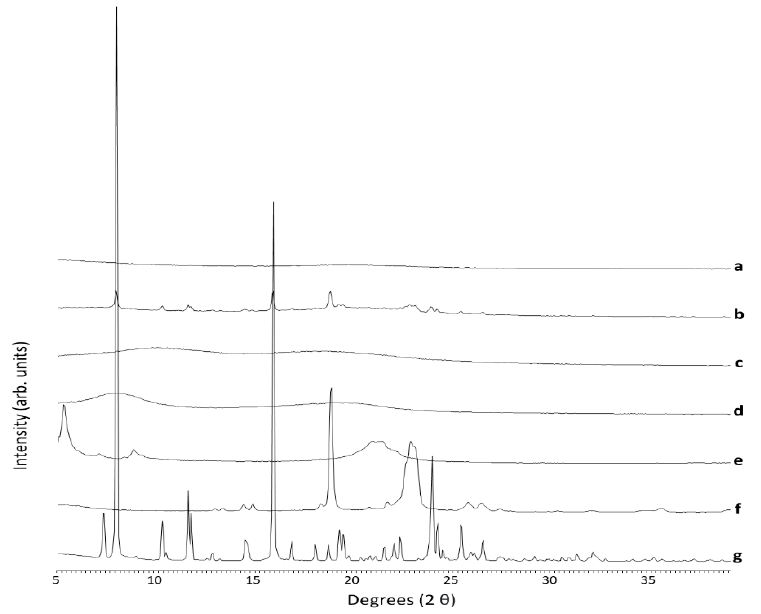
Figure 3. PXRD analysis. Key: ( a ) 3D printed minitablets, ( b ) Physical mixture, ( c ) Unprocessed HPMCAS, ( d ) Unprocessed HPC, ( e ) Unprocessed magnesium stearate, ( f ) Unprocessed PEG 4000, and ( g ) Unprocessed NFD.